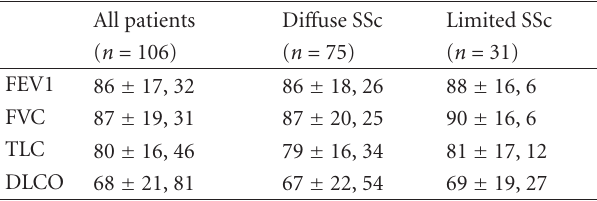
Table 2: Pulmonary function tests (mean ± SD of % predicted, number of patients with less than 80 % of predicted ) in patients with systemic sclerosis